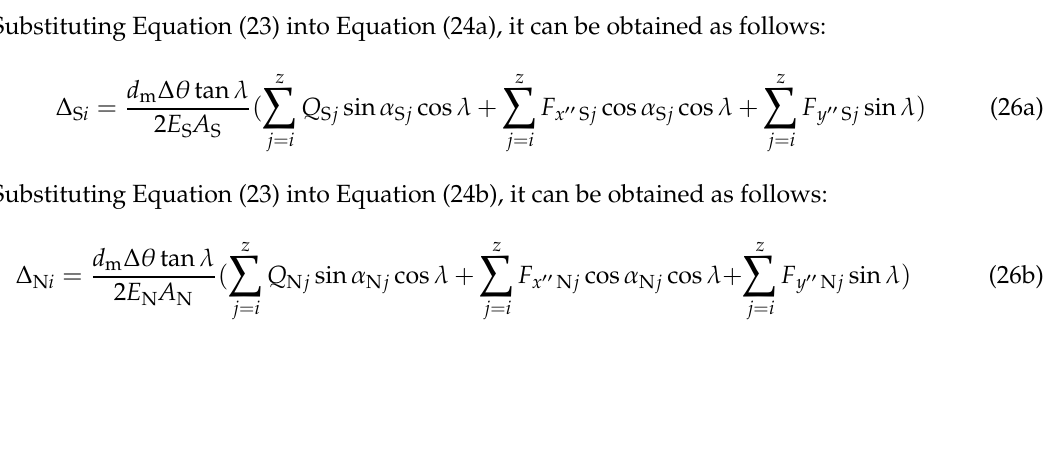
Figure 5. Contact deformations of two adjacent balls in the raceway.